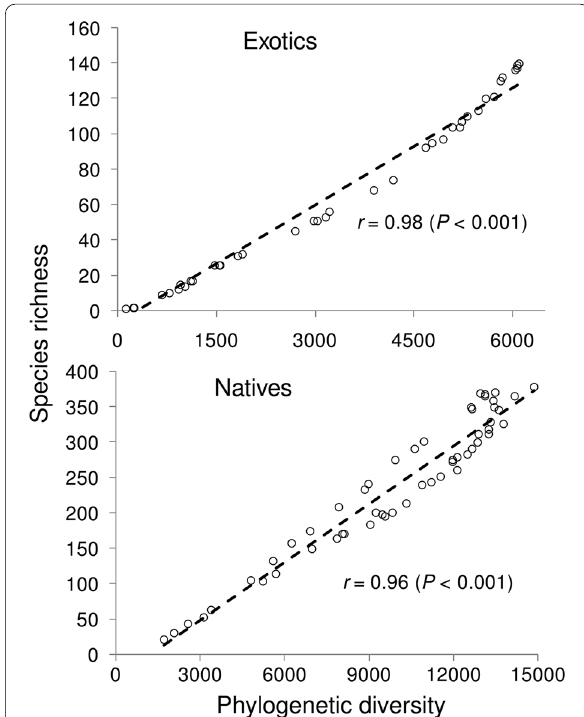
Fig. 4 Relationship between species richness and phylogenetic diversity of exotic and native species along the elevational gradient in the Sikkim Himalayan region. Significant positive correlations were observed between species richness and phylogenetic diversity for both exotic and native species along the elevational